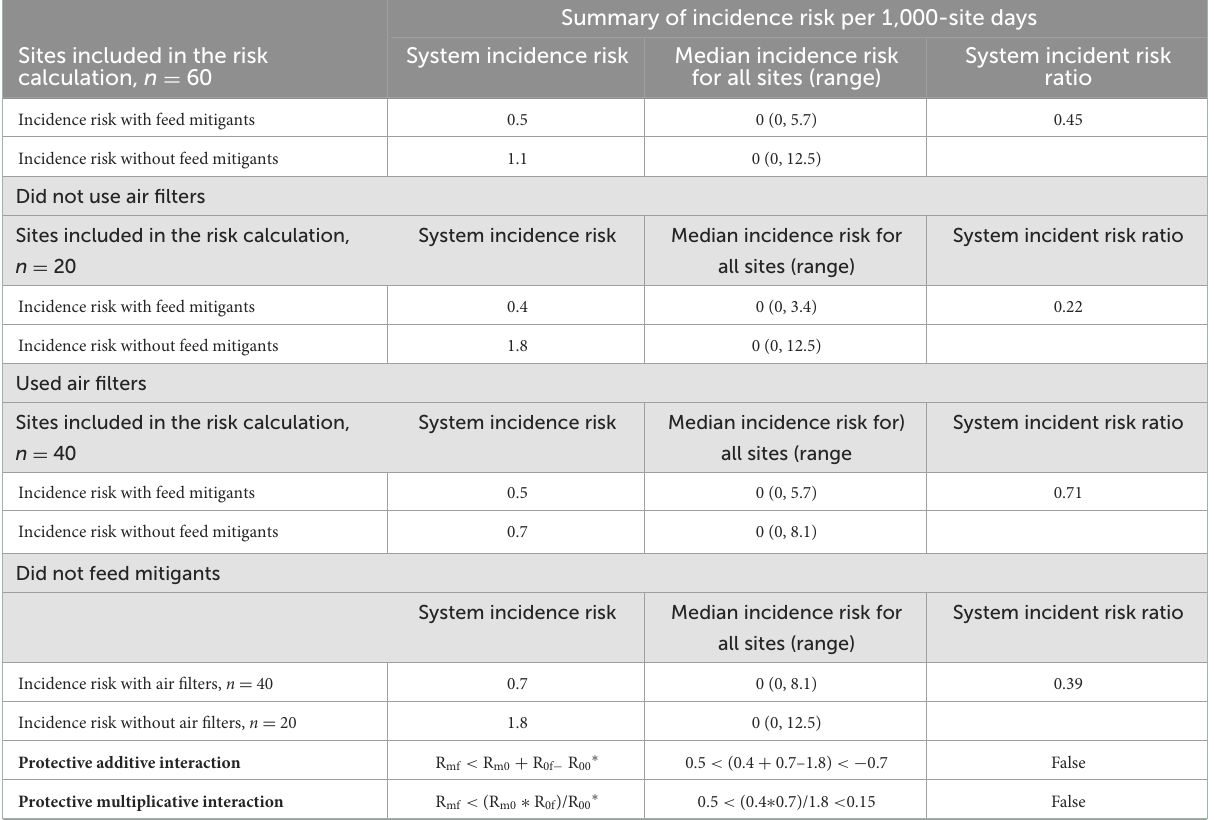
TABLE 4 Incidence of PRRSV infection by 1,000 site-days stratified by feed mitigant and filter use among sites that varied their feed mitigant use in the Pipestone management system from November 2020 to January 2022. Summary of incidence risk per 1,000-site